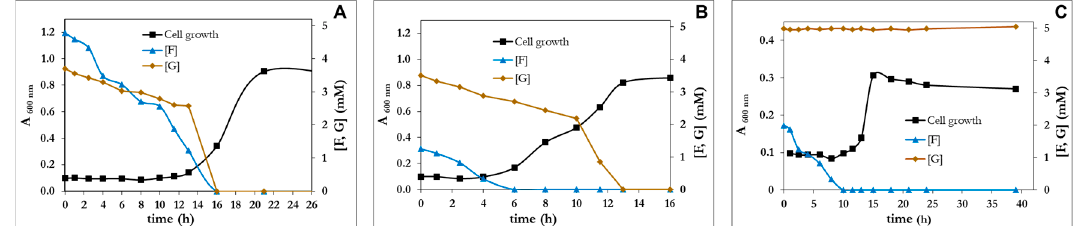
Figure 6. Cell growth of P. pseudoalcaligenes CECT 5344 R1D with glucose 5 mM, supplemented with furfural 5 mM ( A ) or 2 mM ( B ) as carbon sources. ( C ) Cell growth of P. pseudoalcaligenes CECT 5344 R1D edd − with furfural (2.5 mM) and glucose (5 mM) as carbon sources. Glucose and furfural concentration were determined at the indicated times. Similar results were obtained in three different experiments.